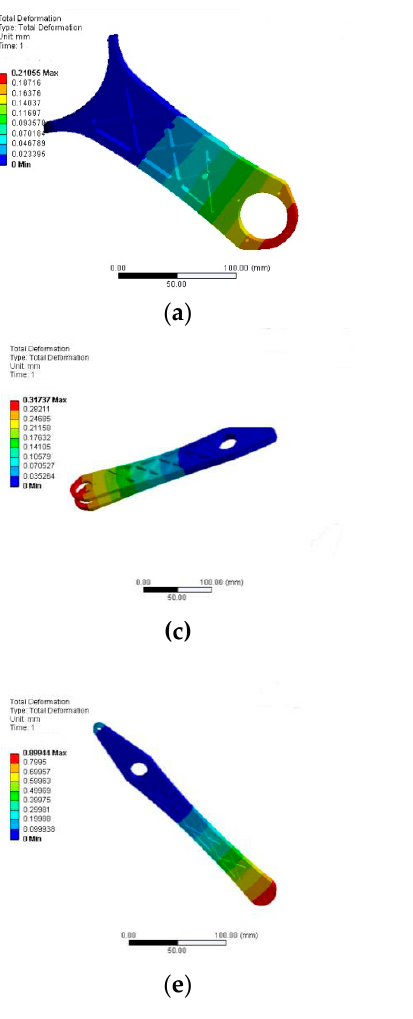
Figure 8. Force calculation by Adams. ( a ) Leg model imported in Adams. ( b ) Forces measured in each part of the leg.